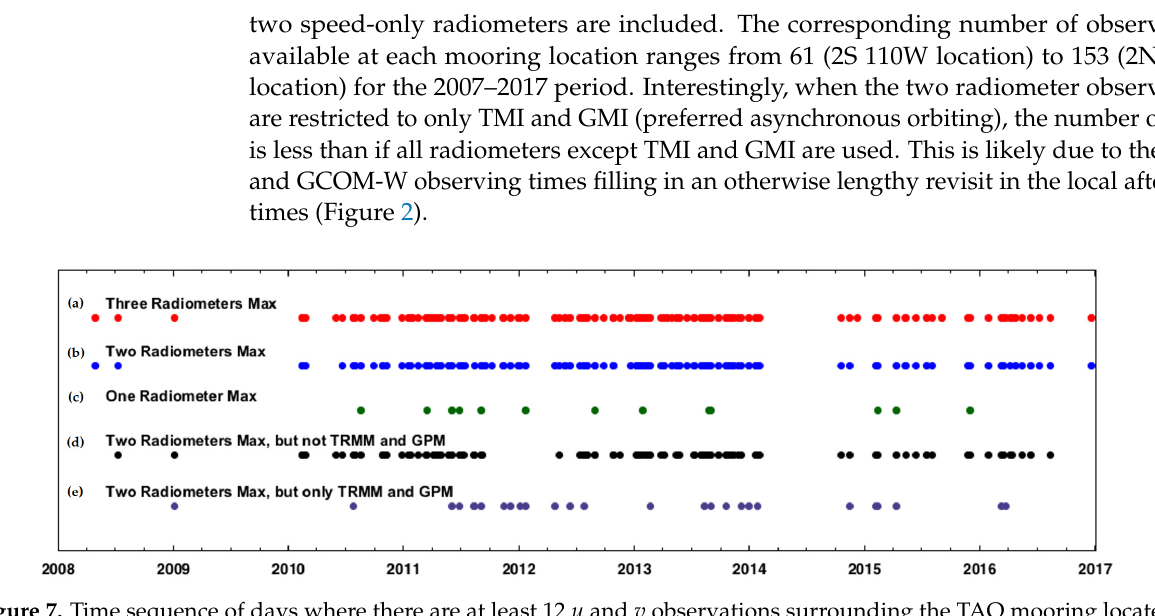
Figure 7. Time sequence of days where there are at least 12 u and v observations surrounding the TAO mooring located at 2S 125W, sufficient to solve Equation (4) with at least two extra degrees of freedom. Each of the five horizontal lines corresponds to a different satellite data acceptance criterion. From top to bottom: (a) All available wind vector observations and up to three radiometers maximum; (b) Same as (a) but two radiometers maximum; (c) Same as (a) but one radiometer maximum; (d) Same as (b) but not allowing TRMM or GPM radiometers; (e) Same as (b) but only allowing TRMM and GPM. The gap in 2014 occurs in the period after OceanSat-2 had ceased functioning but RapidScat had not yet been